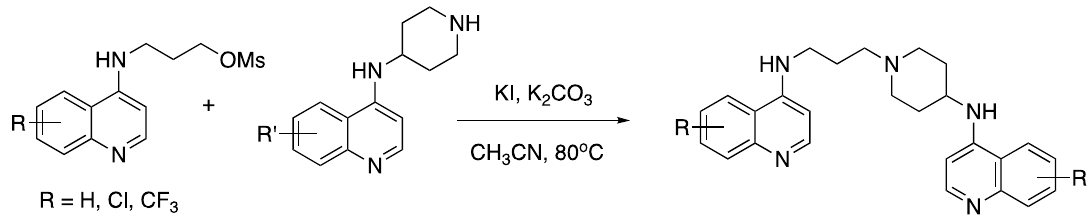
Figure 7. Synthesis of unsymmetrical bisquinoline compounds.